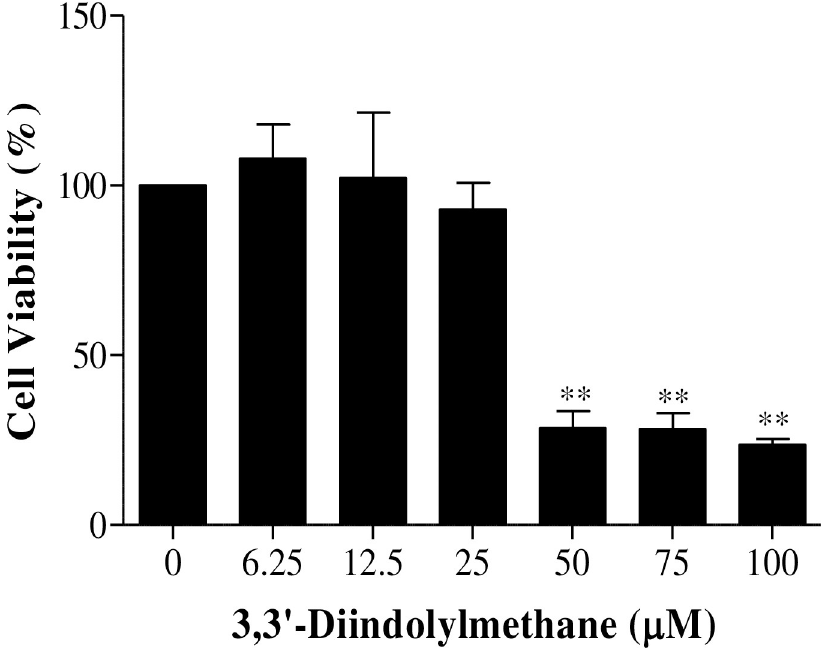
Fig 1. Viability of splenic lymphocytes to 3,3’-Diindolylmethane. Splenic lymphocytes were treated with different concentrations of DIM (0–100 μ M) for 24 h, and cell viability was determined using an MTT assay. Cell viability is expressed as a percent of the viability of the control (untreated, cultured cells), which was set at 100%. Data represent the mean ± SE from three replicates of four independent experiments with similar results. Asterisks ( �� ) indicate a significant difference relative to the control group ( P < 0.01).